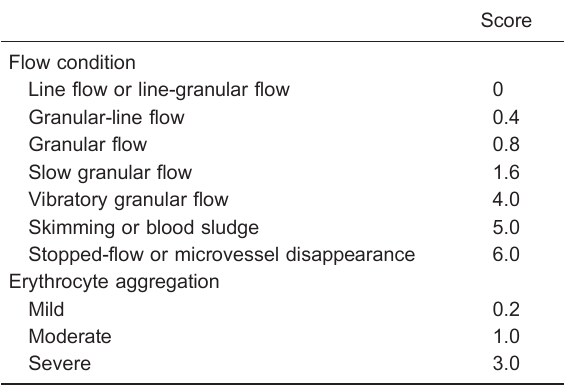
Table 1. Multiple score values of blood microcirculation